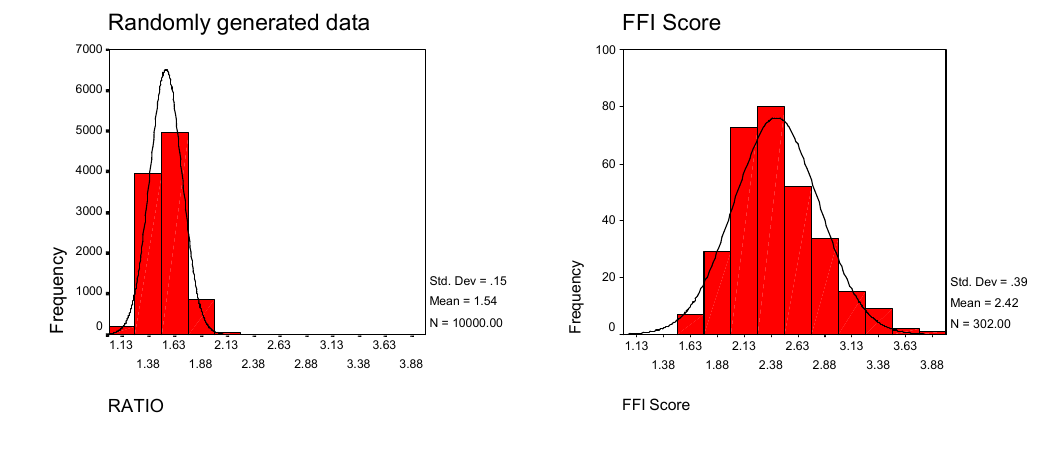
Figure 2: Comparison of Pilot Data with the Phantom Population